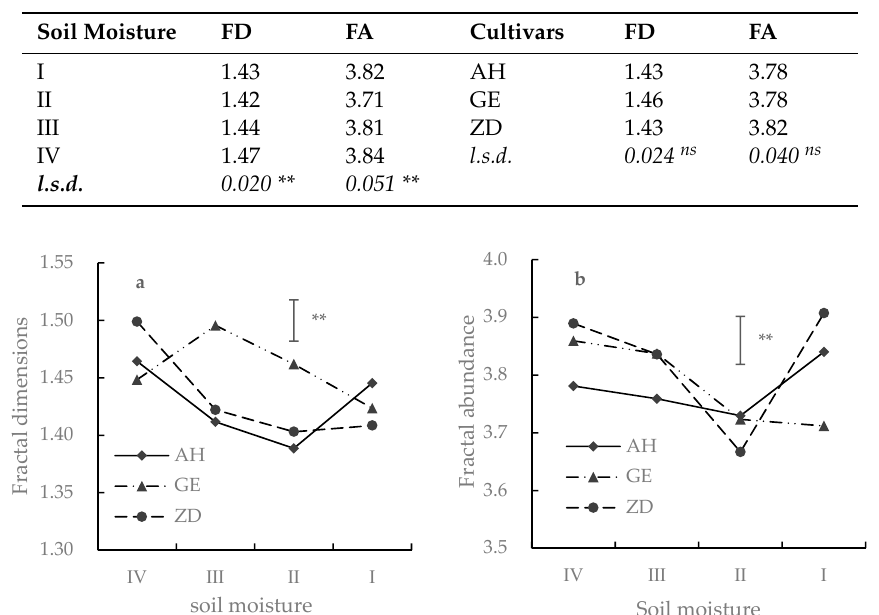
Figure 5. Interaction on ( a ) fractal dimension and ( b ) fractal abundances between cultivars (AH, GE